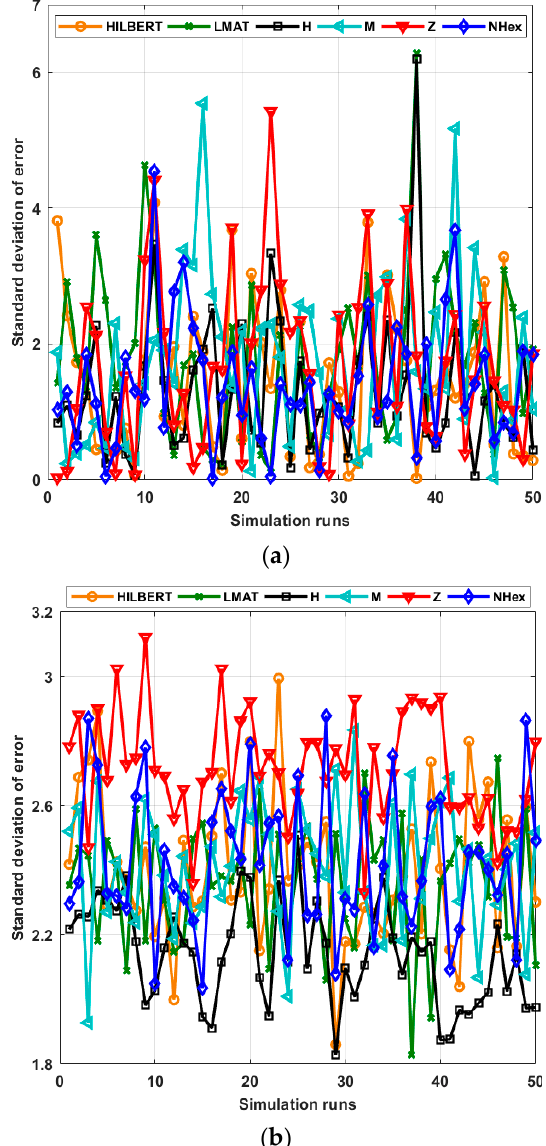
Figure 14. Std of errors of all path planning models in ( a ) WCL, and ( b ) APT. Table 4. Statistical characterization of all mobile path planning models in terms of std of errors for WCL.